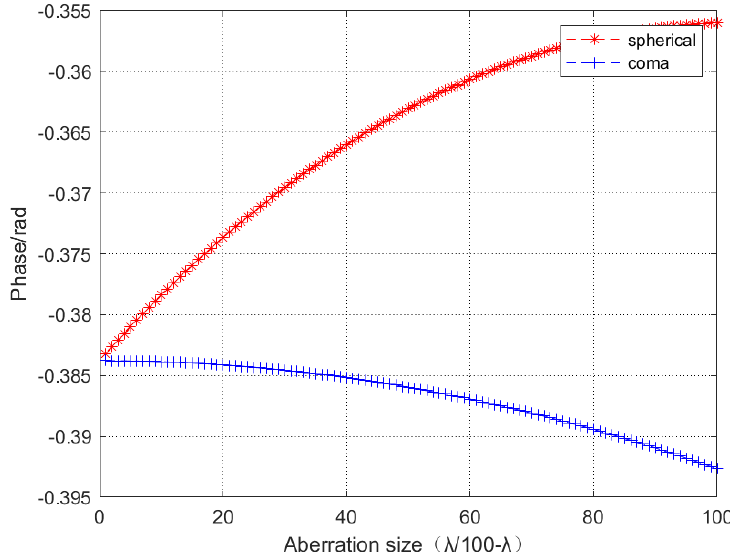
Figure 5. The abscissa refers to the magnitude of the aberration from λ/100 to λ . The ordinate represents the final demodulated phase size. Red represents the phase that changes with the magnitude of the spherical aberration. Blue represents the phase that changes with the magnitude of the coma.